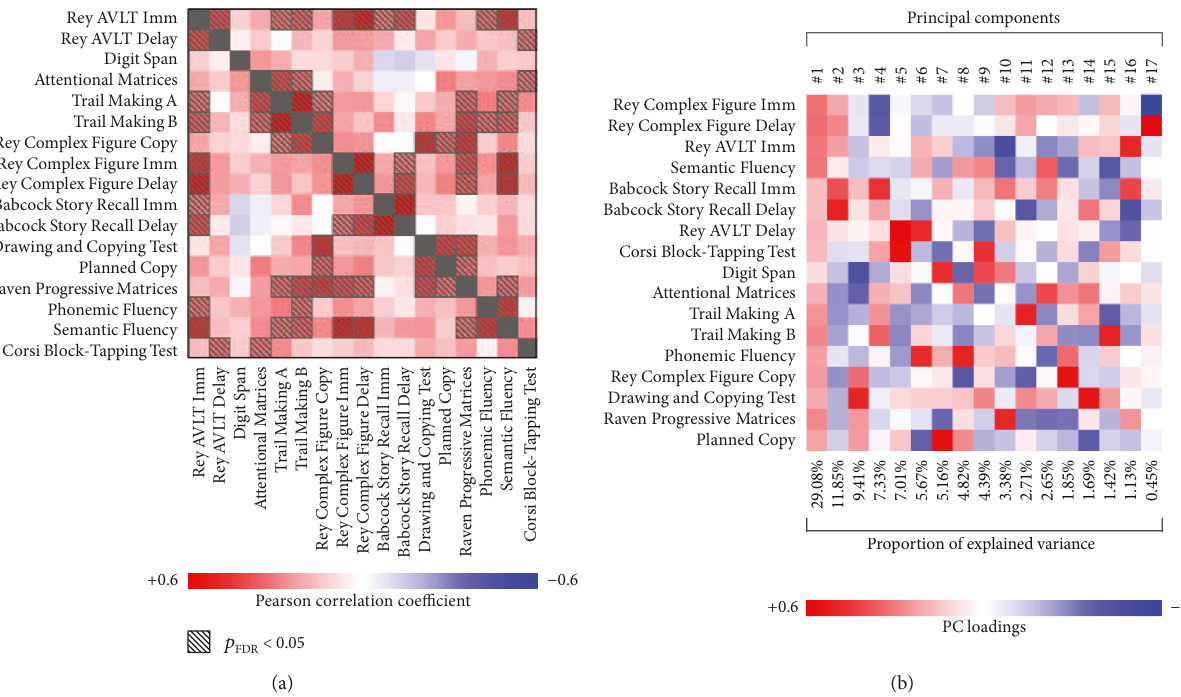
Figure 2: Neuropsychological assessment results. (a) Correlations among all the seventeen neuropsychological tests as estimated by Pearson ’ s coe ffi cient. Marked cells refer to signi fi cant correlations corrected for multiple comparisons through the False Discovery Rate procedure. (b) Matrix describing the results of the principal component analysis and showing seventeen uncorrelated cognitive pro fi les, tests loadings, and the proportion of variance explained by each component. As a matter of fact, the fi rst principal component (explained variance: 29.1%) highlighted subjects ’ global cognitive performance, since all the neuropsychological tests jointly contributed to it and given its high correlation with MMSE scores ( r = 0 522 , p value = 8 2 ∗ 10 − 6 ). AVLT: Auditory Verbal Learning Test; Imm: immediate recall; Delay: delayed Table 1: Predictive power of biochemical markers on cognitive pro fi les.